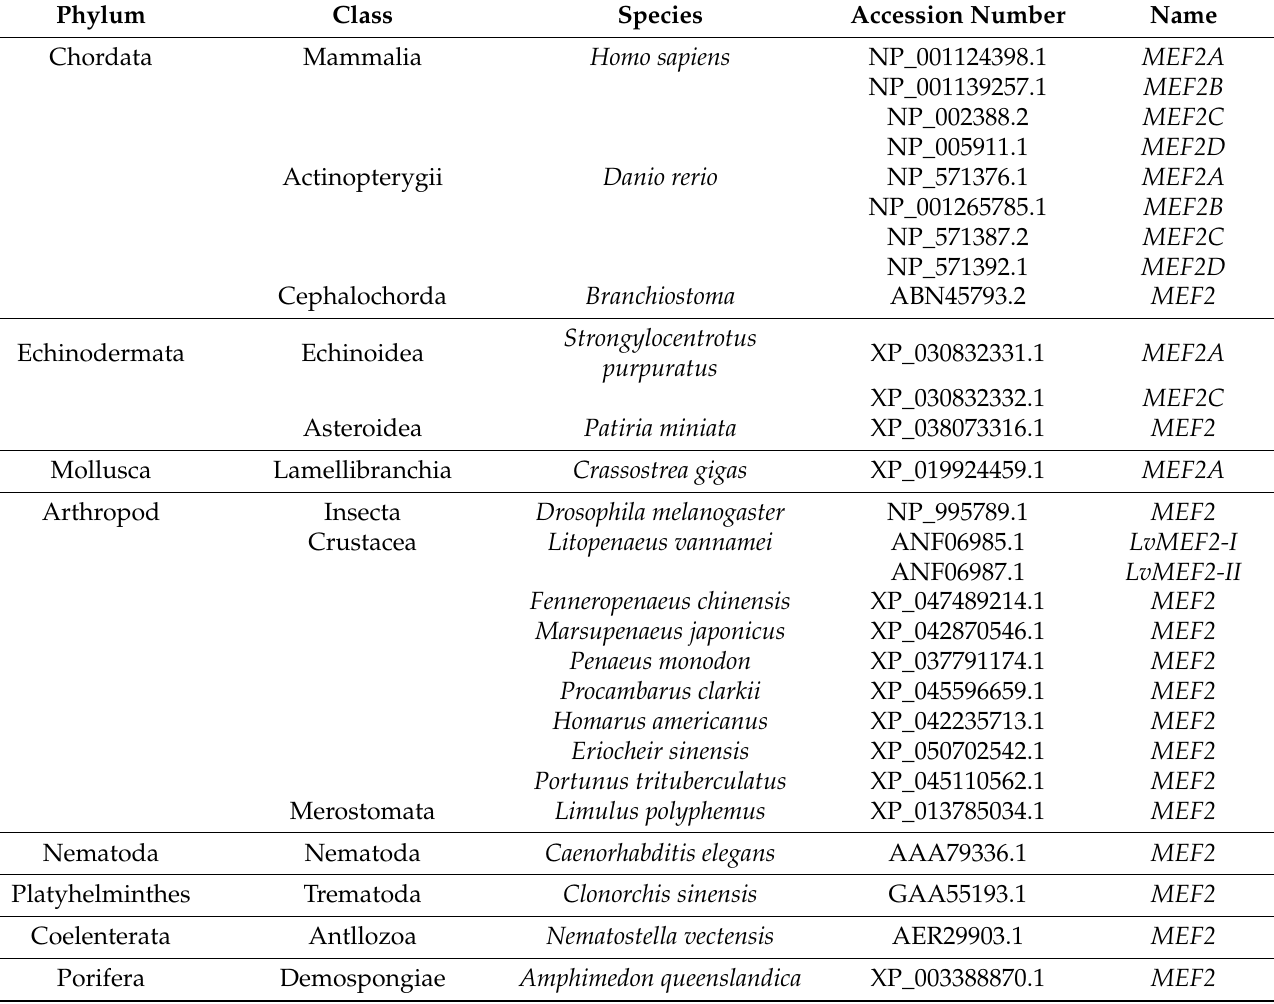
Table 1. MEF2 protein sequences for phylogenetic tree